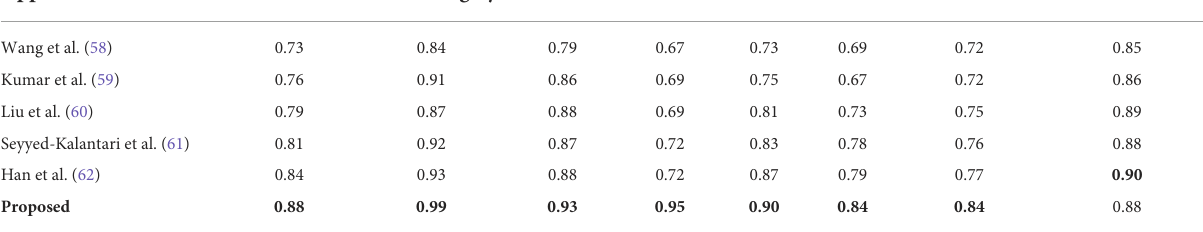
TABLE 7 Comparison of latest approaches in terms of the AUC metric.